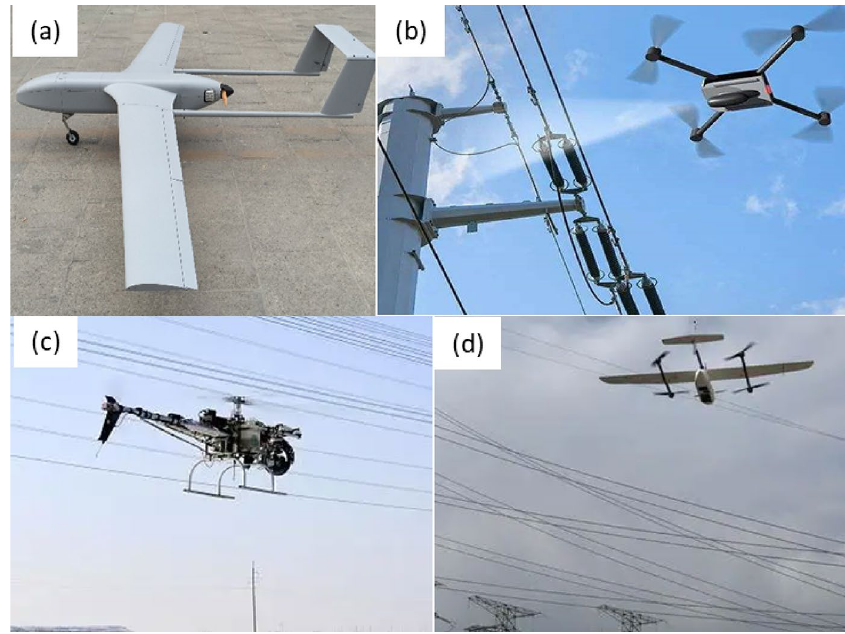
Fig. 1 UAVs used for power line inspection can be divided into: a fixed-wing UAV, b rotary-wing UAV, c unmanned helicopter, and d vertical take- off and landing fixed-wing